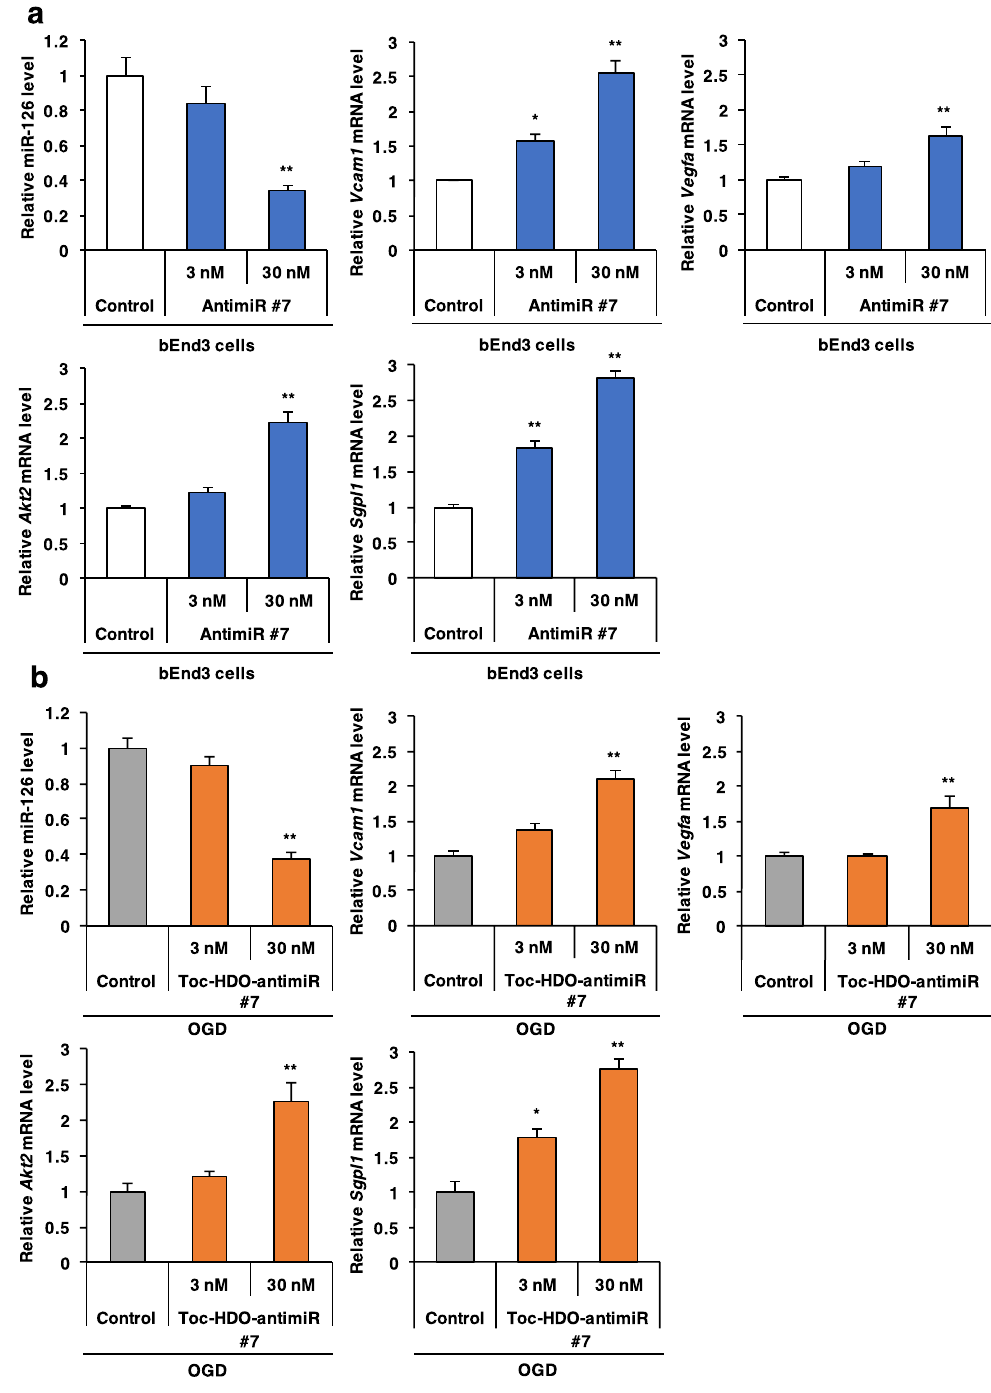
Figure 4. Upregulation of the miR-126 downstream genes by Toc-HDO-antimiR #7 in vitro under ischemia. ( a ) qRT-PCR analysis of the level of miR-126 and the mRNA levels of the candidate miR-126 downstream genes, Vcam1 , Vegfa , Akt2 , and Sgpl1 , in bEnd3 cells transfected with antimiR #7 at 3 nM or 30 nM. ( b ) qRT-PCR analysis of the post- oxygen–glucose deprivation (OGD) level of miR-126 and mRNA levels of the miR-126 downstream genes in bEnd3 cells transfected with Toc-HDO-antimiR #7 at 3 nM or 30 nM. Expression levels are relative to U6 small RNA levels for miR-126 expression experiments and glyceraldehyde-3-phosphate dehydrogenase ( Gapdh ) mRNA levels for mRNA experiments. Data are presented as the mean ± s.e.m. (n = 3 per group; * P < 0.05, ** P < 0.01 versus non-treated control). P values were calculated using one-way ANOVA followed by Dunnett’s